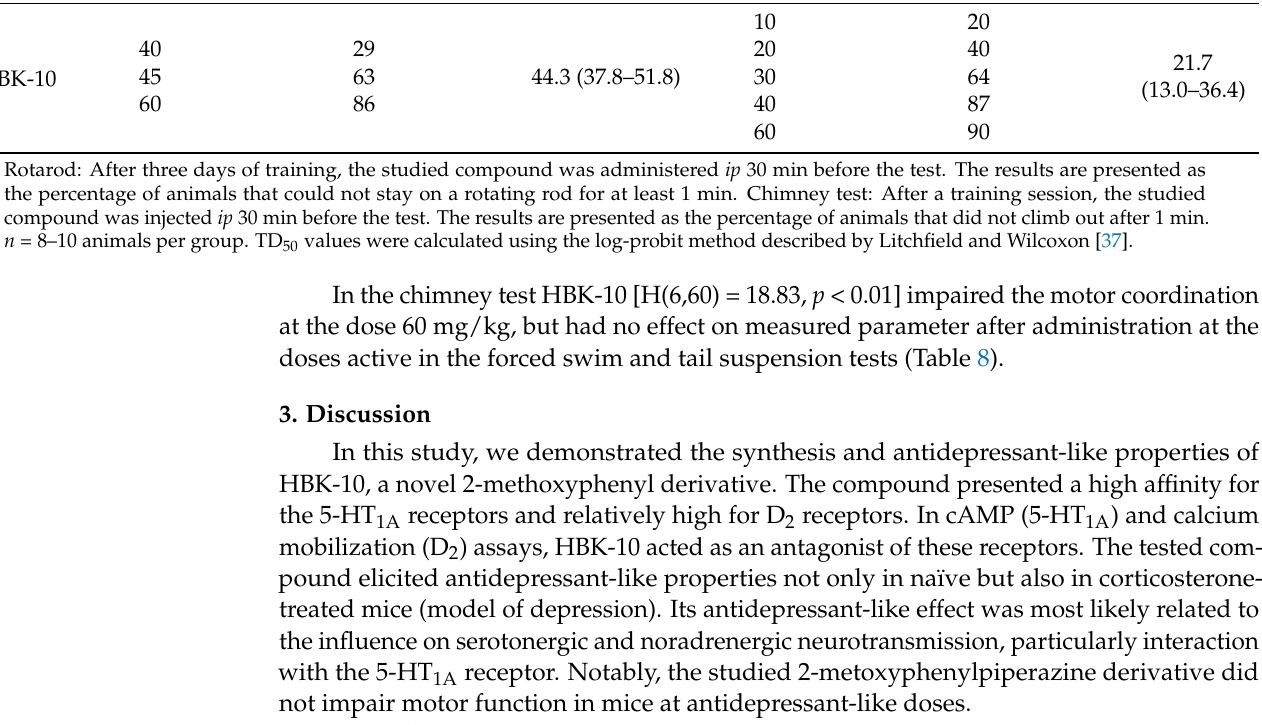
Table 8. The effect of HBK-10 on motor coordination in rotarod and chimney test in mice. Rotarod Test Chimney Test